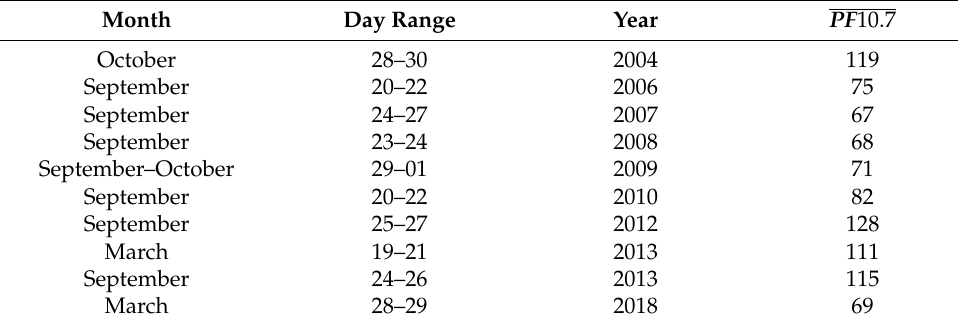
Table 4. Kharkiv ISR Ti measurements intervals for the